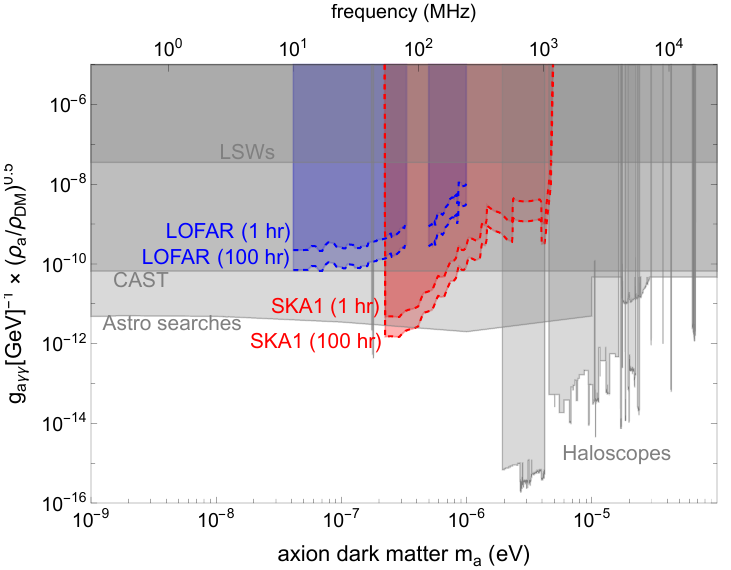
Figure 3. The projected sensitivity of the parameter space of the axion photon dark matter based on the radio telescopes SKA phase 1 and LOFAR, with the observation time assumed to be 1 and 100 h, respectively. The results are translated from Figure 2 via the relation in Equation (21) with | B | taken as 1 Gauss [88]. Together we show the existing constraints, which can be classified into T four categories: the astrophysical searches for axions in various environments, including white dwarfs, neutron stars and pulsars, quasars and blazars, the radio galaxy NGC 1275, globular clusters, etc. [57,92–98]; various haloscope experiments aiming to detect axions in the galactic dark matter halo [100,102,104–125]; the helioscope, CAST, aiming to detect axions emitted by the Sun; and light- shining-through-a-wall (LSW) experiments including CROWS, ALPS, and OSQAR [89–91]. The existing constraints are also nicely summarized in